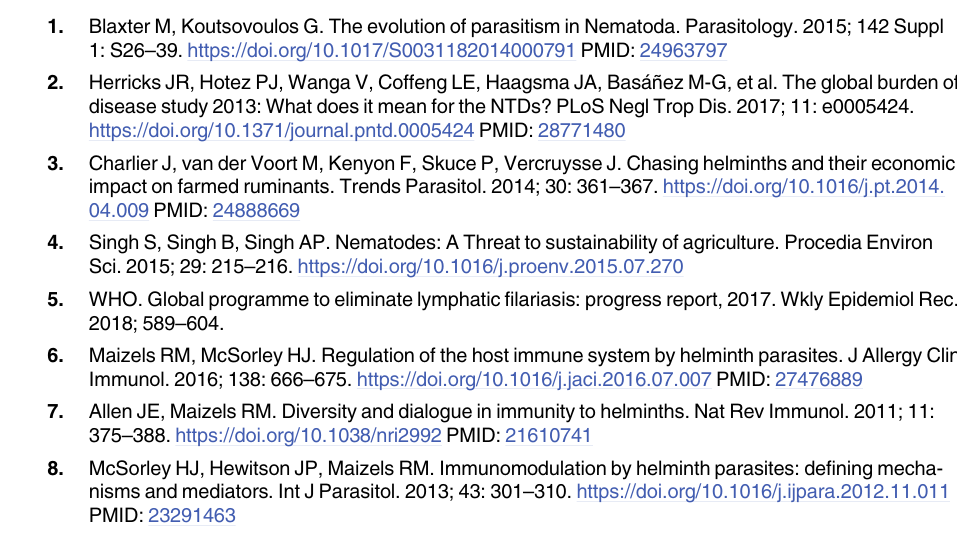
S1 Table. Analyzed C . elegans secretome. S2 Table. Pfam accession